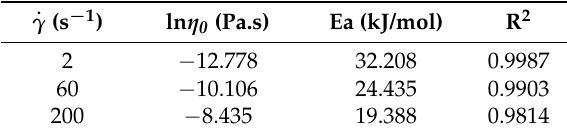
Table 2. Fitting parameters of Arrhenius equation for 2% ( w / v ) TSP